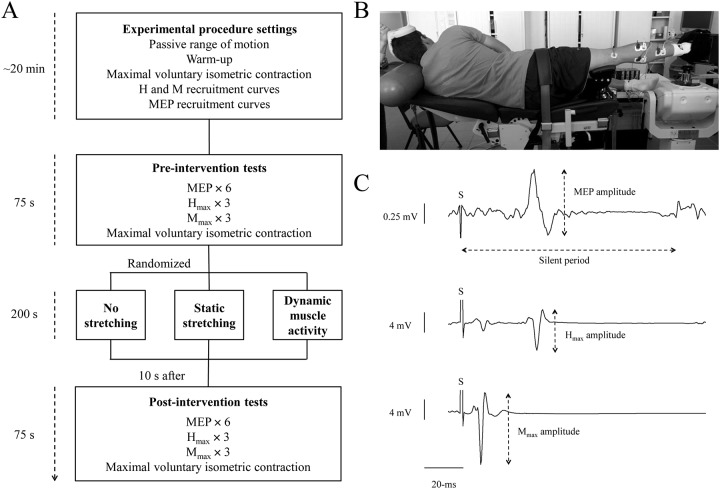
(A) Timeline of the experimental protocol showing the three (randomized) interventions. (B) Experimental setup with the subject in the neutral position. (C) A representative recording showing MEP, Hmax and Mmax electrical responses in soleus during a submaximal (30% MVIC) isometric contraction. S: Stimulation imposed.